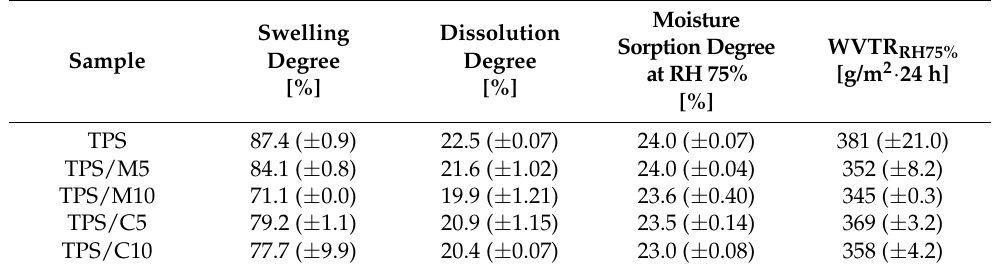
Table 2. Swelling and dissolution degrees of TPS films distilled water, moisture adsorption degree and WVTR at 75% for 24 h.